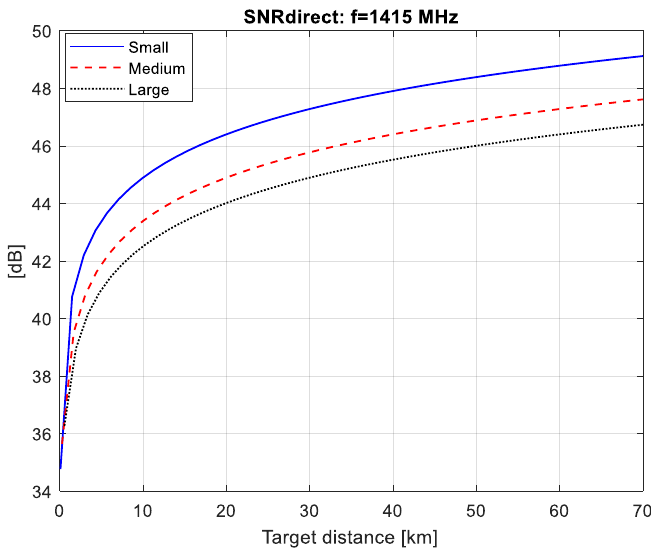
Figure 8. 𝑆𝑁𝑅 𝑑𝑖𝑟𝑒𝑐𝑡 values for solar FSR.